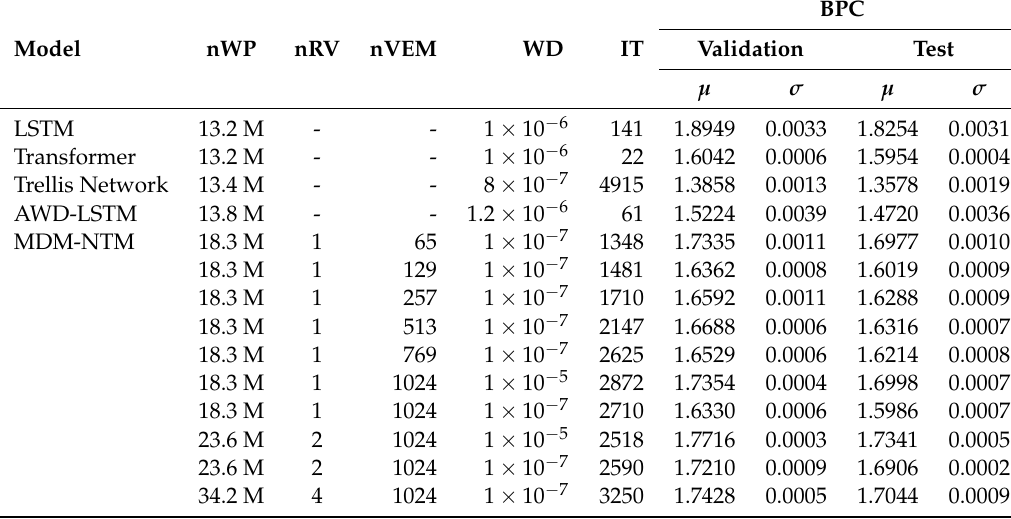
Table 1. Evaluation results of MDM-NTM-based LMs on the PTB LM task (nWP, number of weight parameters; nRV, number of read vectors; nVEM, number of vectors in the external memory; WD, weight decay; IT, inference time (ms/batch); µ , mean of BPC results; σ , standard deviation of BPC